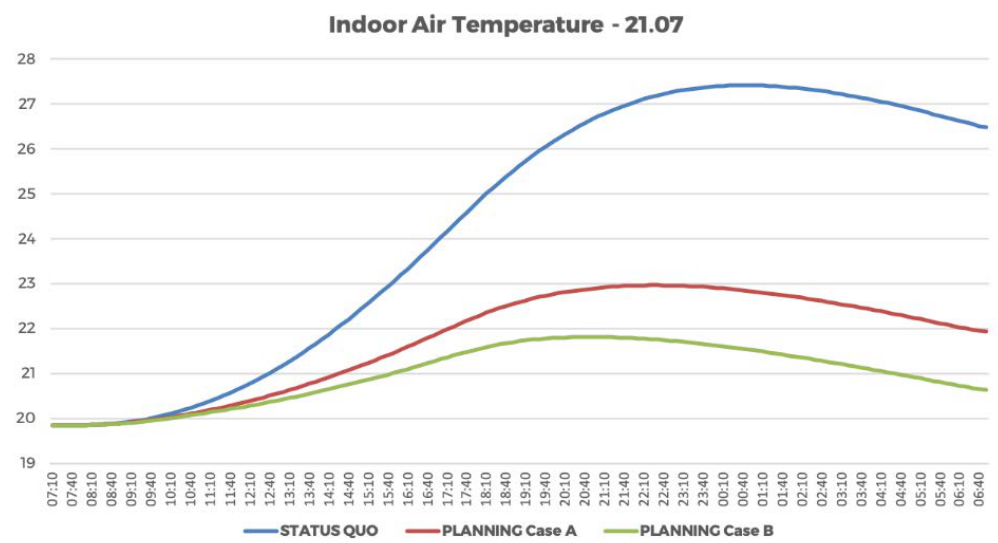
Figure 11. Key performance indicator (KPI) indoor air temperature (IAT) day profile for Elief Playhouse Antwerp scenarios on an idealized typical hot summer day (21.07).